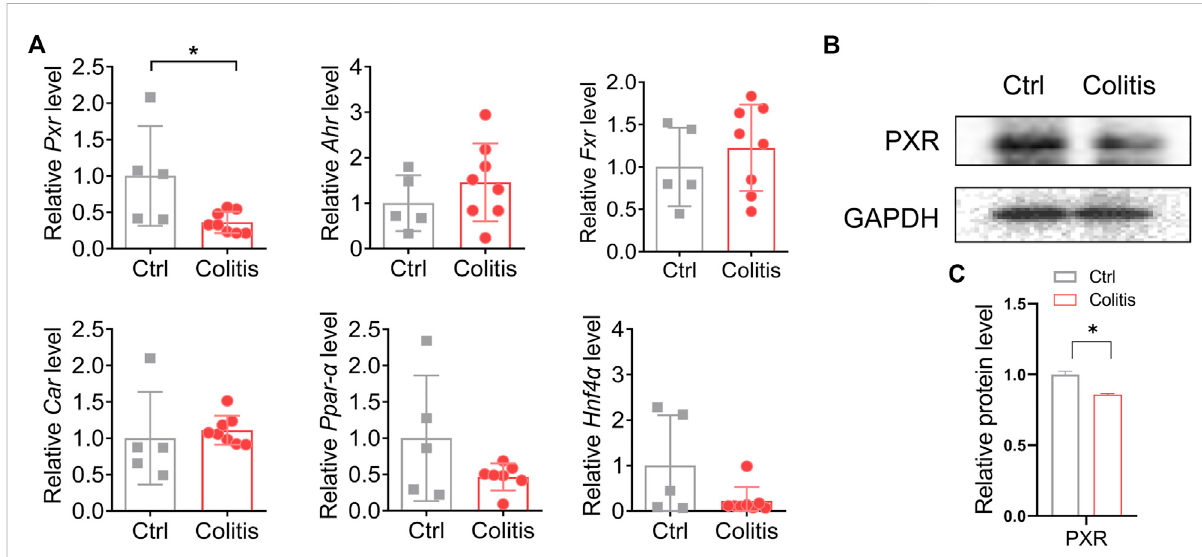
FIGURE 4 PXR is associated with the inhibitory effects of colitis on UGT1A1 and UGT1A9. (A) mRNA expression of PXR, AHR, FXR, CAR, PPAR α , and HNF4 α in the liver of colitis and control mice. (B) Protein expression levels of PXR in the liver of colitis and control mice. (C) Quantitative data of Western blotting in (B) . * p <